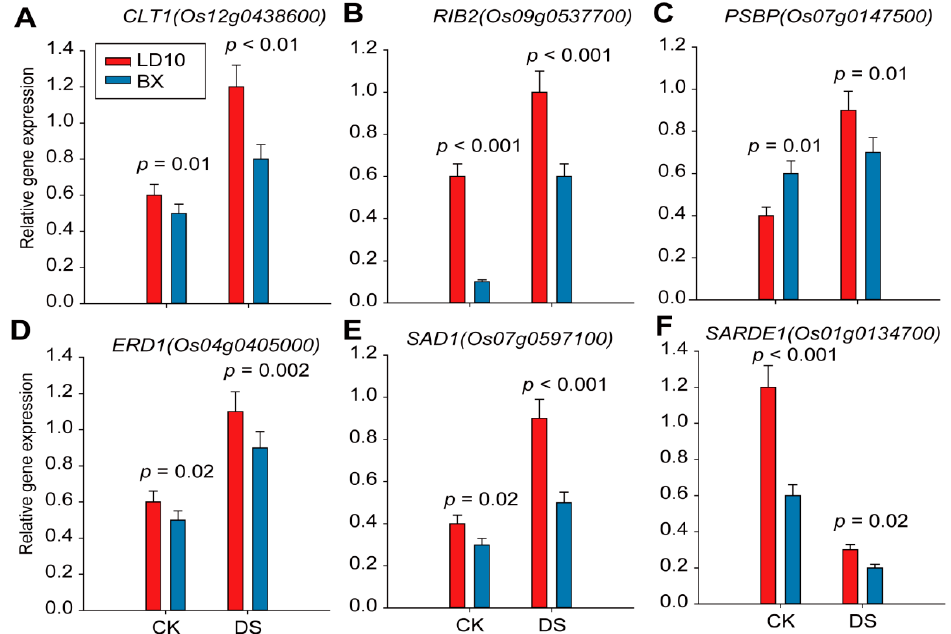
Figure 7. qRT-PCR results showing the relative expression levels of six genes that tightly correlated with δ 13 C values in two rice accessions in either CK or drought conditions at 10 DAT. ( A – F ) Relative expression levels of genes, namely CLT1 (Os12g0438600), RIB2 (Os09g0537700), PSBP (Os07g0147500), ERD1 (Os04g0405000), SAD1 (Os07g0597100), and SARDE1 (Os01g0134700). Values represent mean ± standard deviation ( n = 3). Student’s t -test was used to represent the significant levels, where different letters stand for significant levels at p < 0.05.